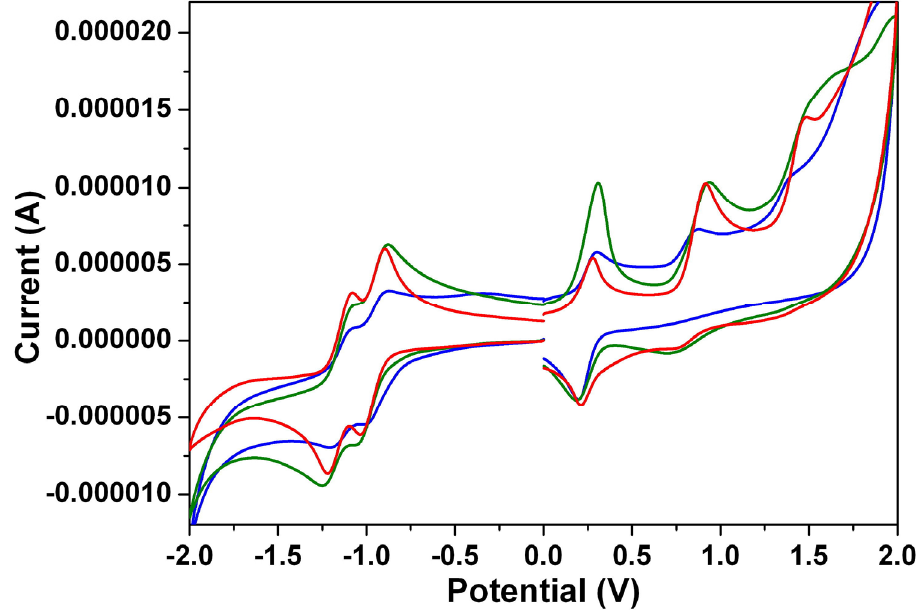
Figure 8. The cyclic voltammograms of 1a (blue line), 1b (green line) and 1c (red line) measured in dichloromethane solution with ferrocenium/ferrocene as an internal standard, at 200 mV·s − 1 .